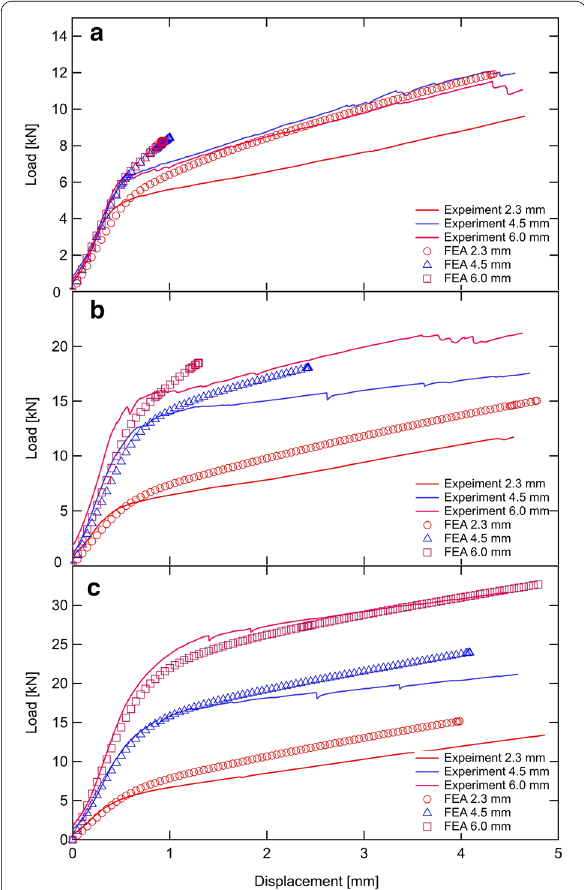
Fig. 3 Embedment load–displacement curves obtained via experiments and FEA. Side lengths of metal washers are ( a ) 40, ( b ) 60, and ( c ) 80